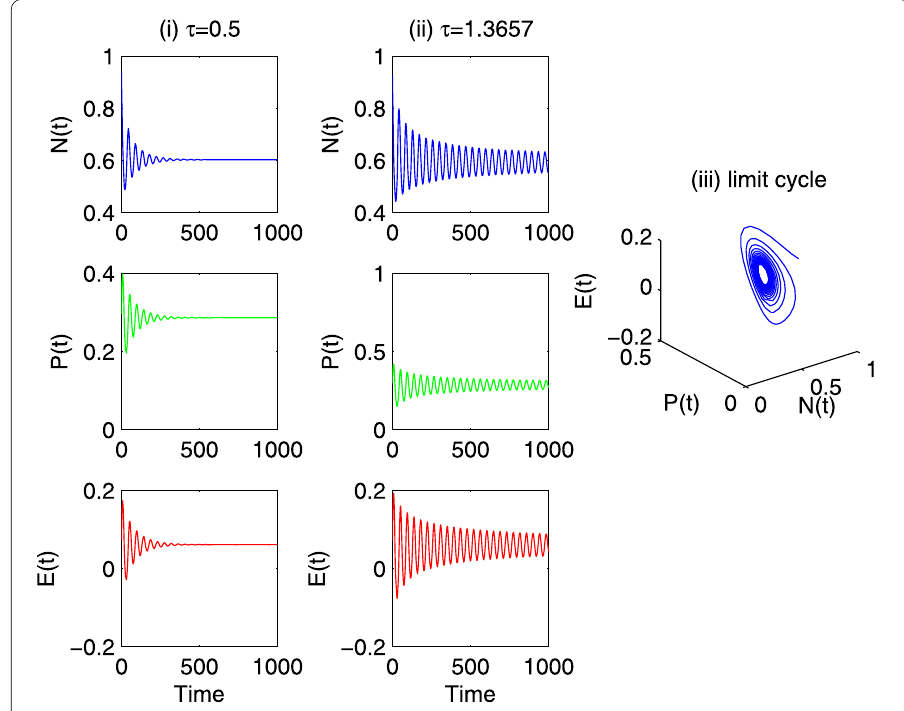
Figure 1 In the case of strong Allee effect, dynamical variations of prey, predator biomass, and harvest amount with the increasing time with τ = 0.5 and τ = 1.3657, which are indicated in Fig. 1(i) and Fig. 1(ii), respectively. The limit cycle around ˜ S ∗ s = (0.6029,0.2891,0.0640) corresponding to Fig. 1(ii) is plotted in Fig.